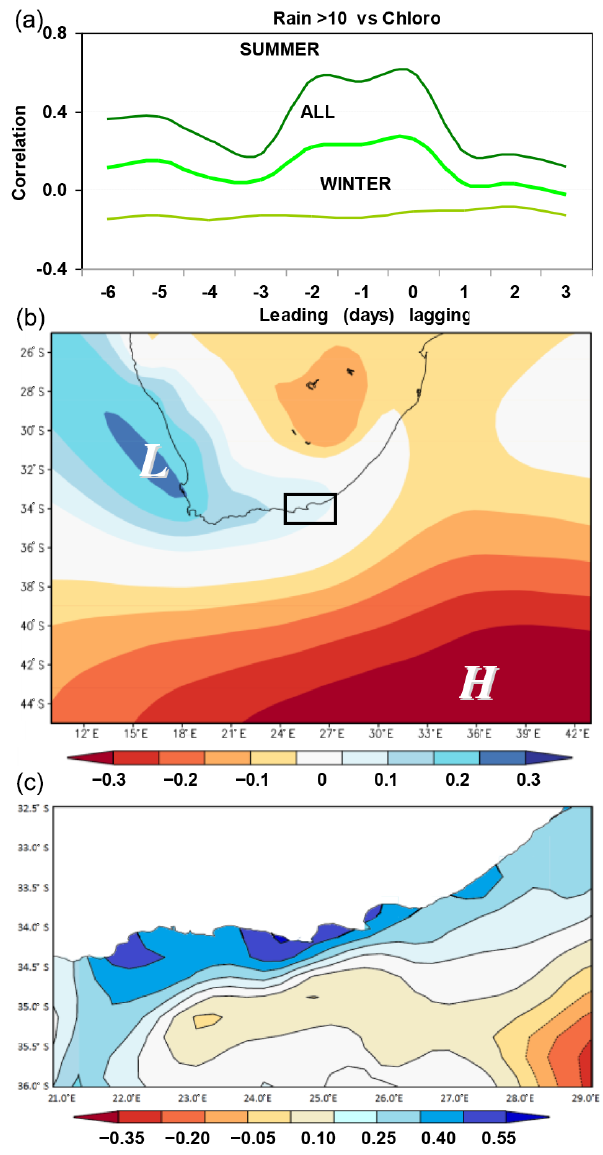
Figure 6. (a) Lag correlations between index-area coastal rainfall >10mmd − 1 and chlorophyll fluorescence ( N = 102) for summer, all, and winter seasons. (b) Point-to-field correlations of salinity in- dex (see Fig. 4d) and sea-level air pressure at 3d lead, based on October–March 2006–2017 data; icons are given with respect to lower salinity. (c) Same point-to-field correlations except with sea surface height anomalies, shaded with respect to lower salinity (e.g., low